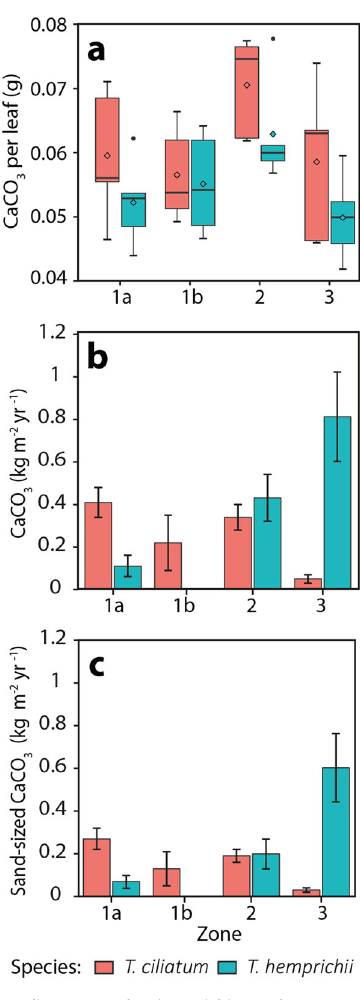
Fig. 3 Epibiotic sediment production within each seagrass zone. a The mass of sediment (CaCO 3 ) per seagrass leaf associated with Thalassodendron ciliatum and Thalassia hemprichii within each zone, as determined through loss after acidi fi cation analyses. The box limits are the lower (Q1) and upper (Q3) quartiles, and the median is represented by the centre lines. Whiskers represent the minimum and maximum values before the lower and upper fences, respectively. Diamonds represent the mean. Rates of b total and c sand-sized sediment production associated with each species within each seagrass zone. Error bars represent the cumulative errors 6